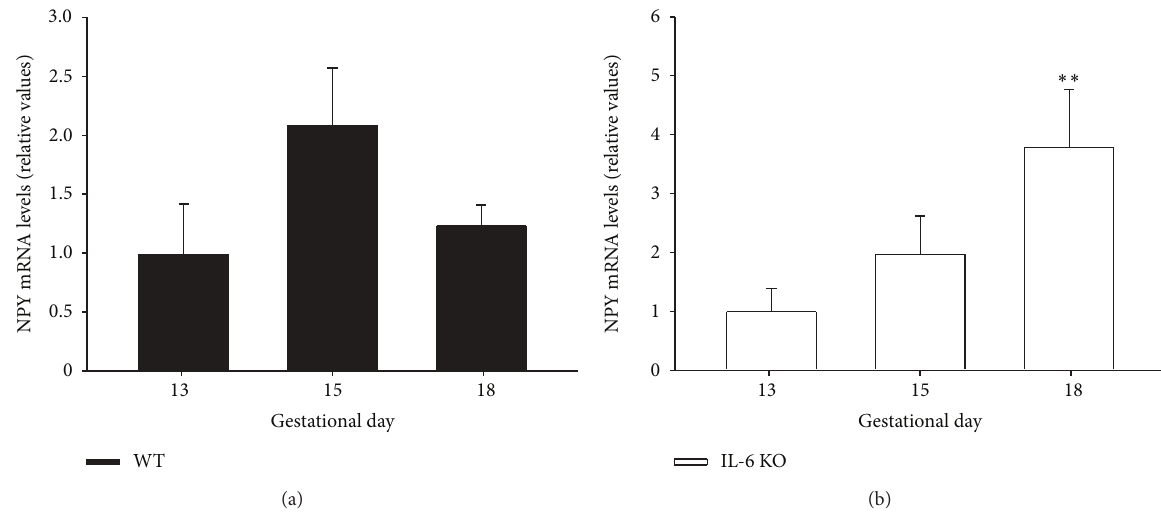
Figure 3: NPY mRNA expression in placenta of WT and IL-6 KO mice. 12-week-old WT and IL-6 KO mice were time-pregnant and placental NPY mRNA levels in (a) WT and (b) IL-6 KO mice at different pregnancy stages (13, 15, and 18 days) were assessed by real-time qPCR; 𝑛 = 5 - 6 . Within each genotype, relative mRNA levels were normalized to 13 days pregnant mice values as 1. Each value represents the mean ± SEM. One-way ANOVA: ∗∗ 𝑃 < 0.01 versus 13 days pregnant mice of respective genotype.